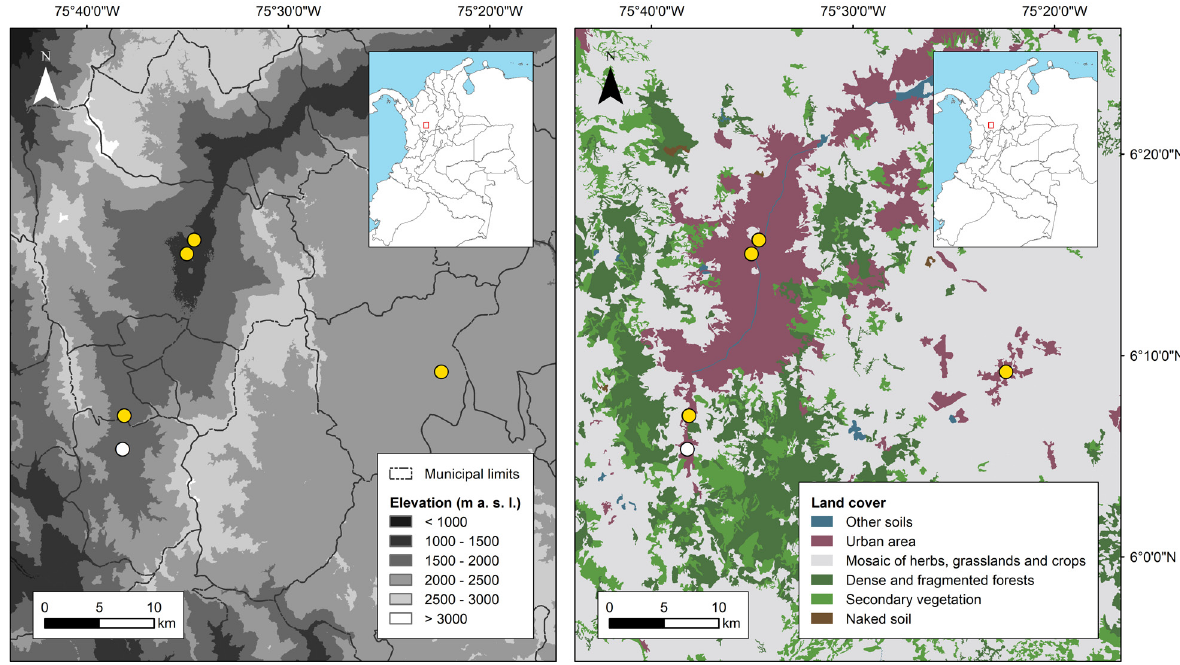
Figure 1. Records of H. garnotii in Colombia. Yellow circles: records with voucher specimens in a biological collection; white circle: personal observations confirmed (from the municipality of Caldas, Antioquia; JDV-R pers. obs.). Both maps show the same geographical area but with different base information, altitudinal gradient on the left and land cover on the right. Notice that records of H. garnotii are only know from urban